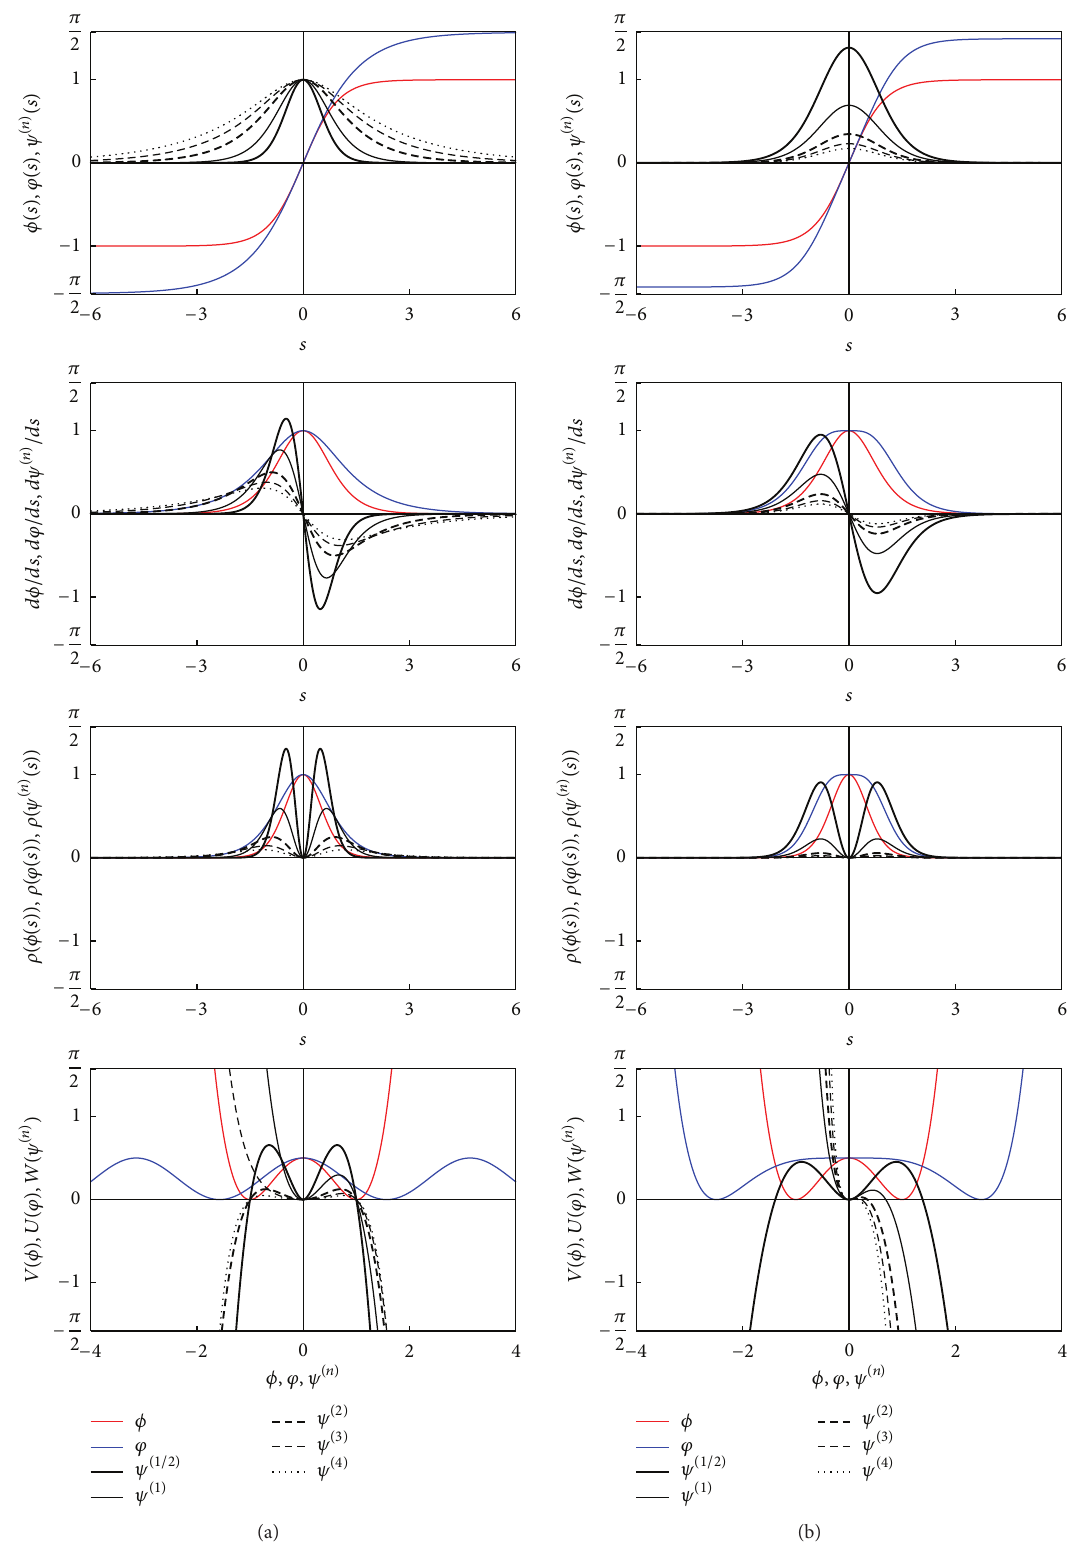
Figure 1: First family (first column) and second family (second column) of 3 -cyclically deformed defects. The figure shows the results for the primitive defects (red lines): 𝜙(𝑠) , 𝑦 𝜙 (𝑠) = 𝑑𝜙/𝑑𝑠 , and 𝑉(𝜙) ; for the kink-like deformed defects (blue lines): 𝜑(𝑠) , 𝑥 𝜑 (𝑠) = 𝑑𝜑/𝑑𝑠 , and 𝑈(𝜑) ; and for the lump-like deformed defects (black lines): 𝜓 (𝑛) (𝑠) , 𝑧 𝜓 (𝑠) = 𝑑𝜓 (𝑛) /𝑑𝑠 , and 𝑊(𝜓) . The solutions related to 𝜓 (𝑛) (𝑠) are computed for 𝑛 = 1/2 (thick line), 1 (thin line), 2 (long-dashed line), 3 (short-dashed line), and 4 (dotted